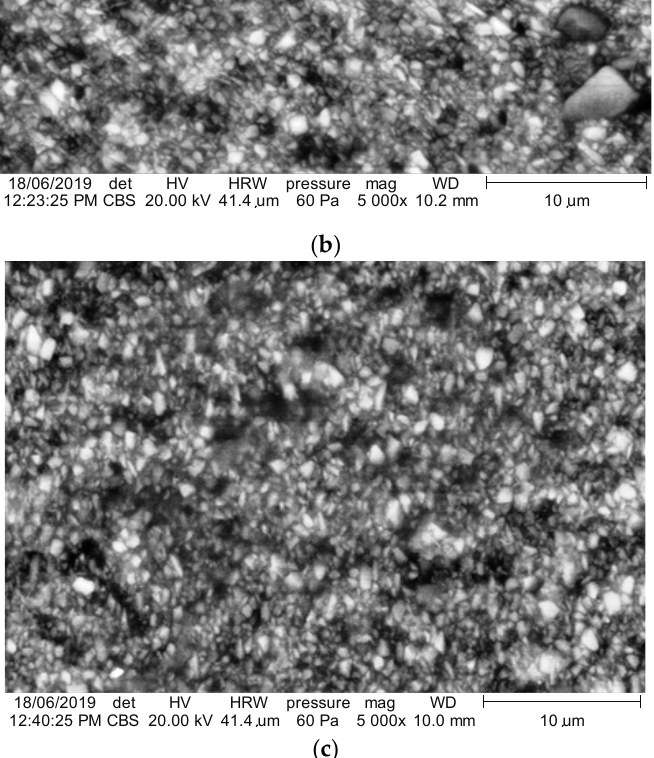
Figure 1. SEM microimages of the fractured surfaces of the composite structures: ( a ) Z550, ( b ) Ex-nano (G), ( c ) Ex-flow (G).